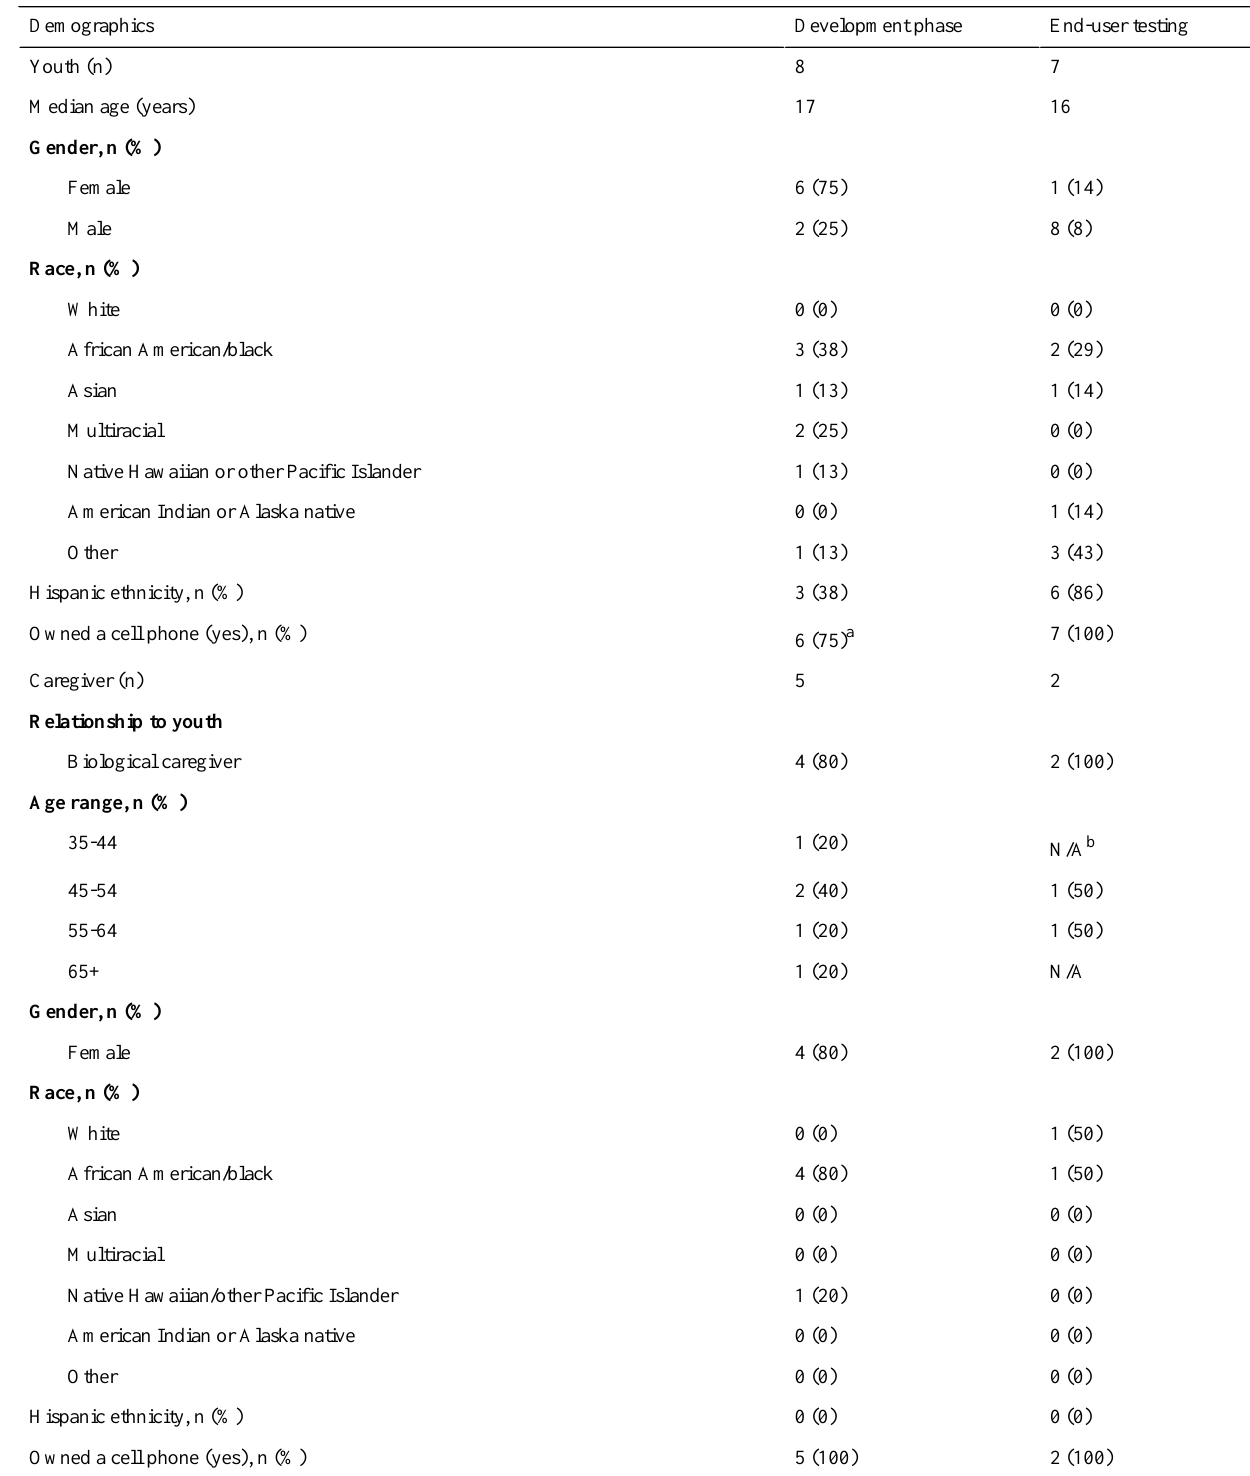
Table 1. Demographic characteristics of court-involved, nonincarcerated youth and